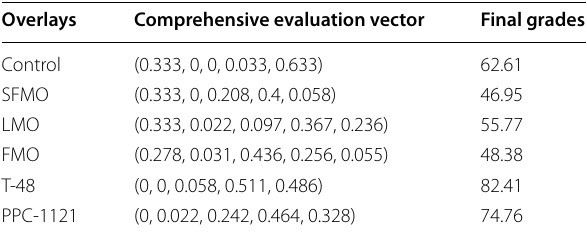
Table 12 Comprehensive evaluation vector and final grades of overlays in